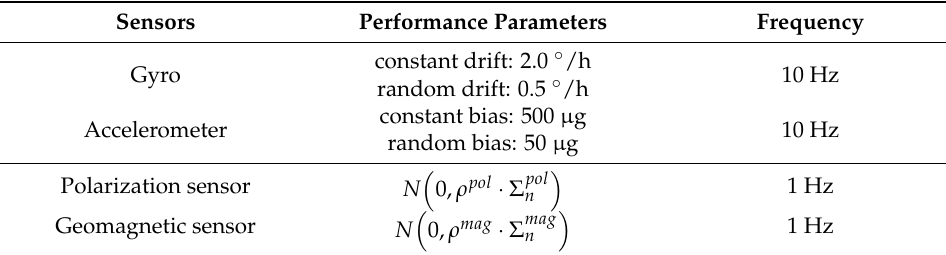
Table 1. The performance parameters of sensors in the simulation.